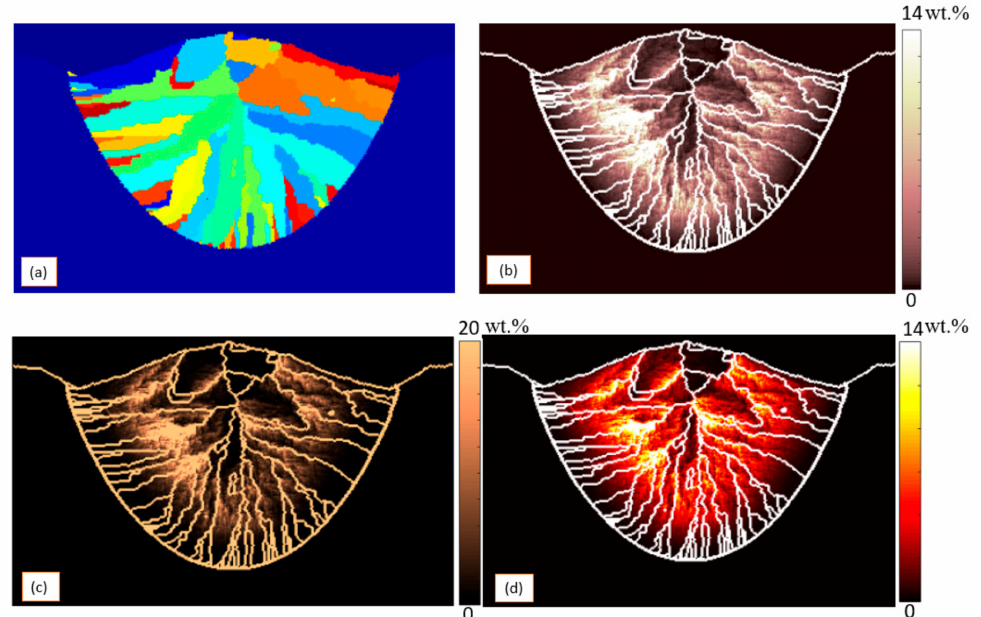
Figure 2. Simulation results for solidification behavior at 360 J/m. ( a ) grain structure inside the track; ( b ) Nb concentration after laser melting; ( c ) Ti concentration after laser melting; ( d ) C concentration after laser melting.